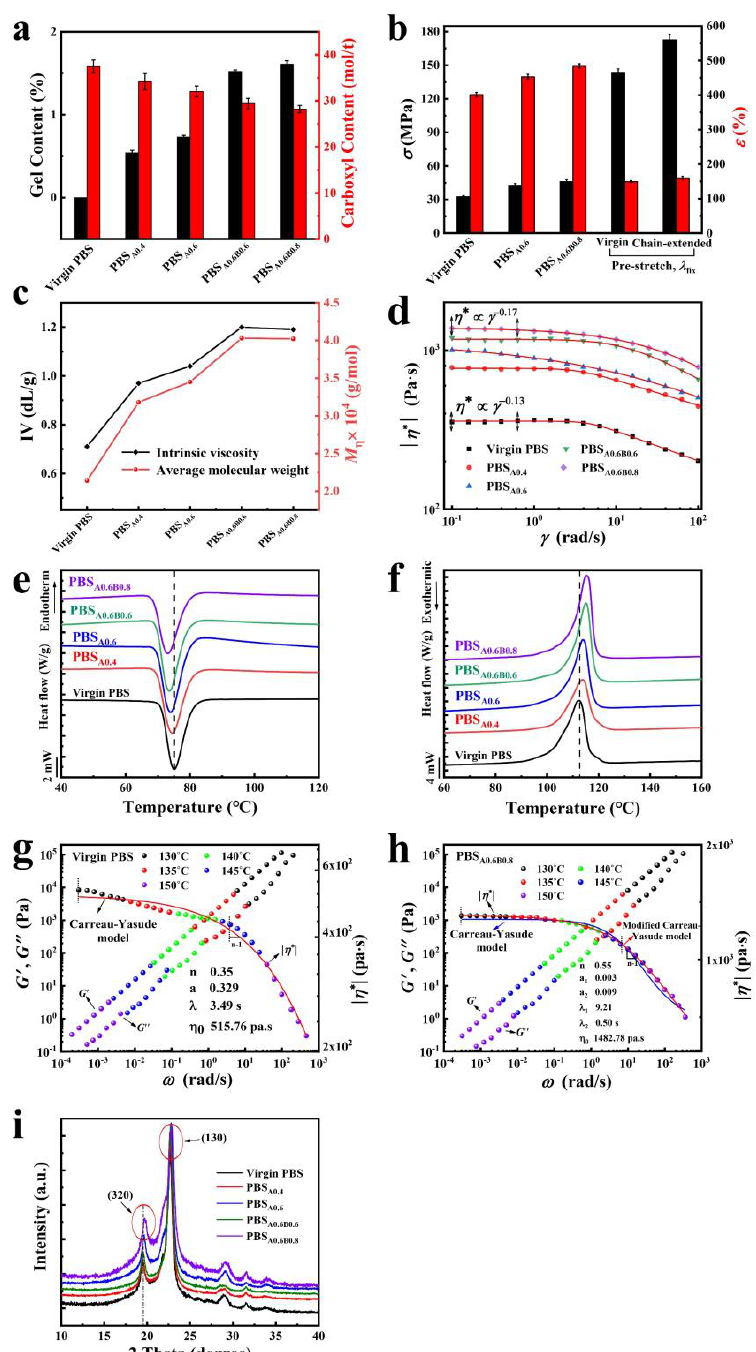
Figure 2. Measurement of two-steps chain extension factors of PBS. ( a ) Variation of gel fraction and carboxyl group content of PBS samples. ( b ) The tensile strength and elongation at break of chain-extended PBS were obtained at a rate of extension of 20 mm min − 1 at room temperature. ( c ) Intrinsic viscosity and average-molecular weight of PBS samples. Non-isothermal crystallization curves for PBS samples at 140 °C. ( d ) Double logarithm diagram of complex viscosity changing with angular frequency at 150 °C and 1 ~ 100 rad s − 1 . ( e ) Cooling curve (10 °C min -1 ), ( f ) heating curve (10 °C min − 1 ). Viscosity function ( η *), storage ( G ′) and loss modulus ( G ″) of (g) virgin PBS and ( h ) long-chain branched PBS A0.6B0.8 with best fits based on the Carreau-Yasuda model. Detailed measure methods can be found in the Supplementary Information. ( i ) WAXS patterns of PBS samples by fitting in Jade with 2θ from 5 ° to 90°.